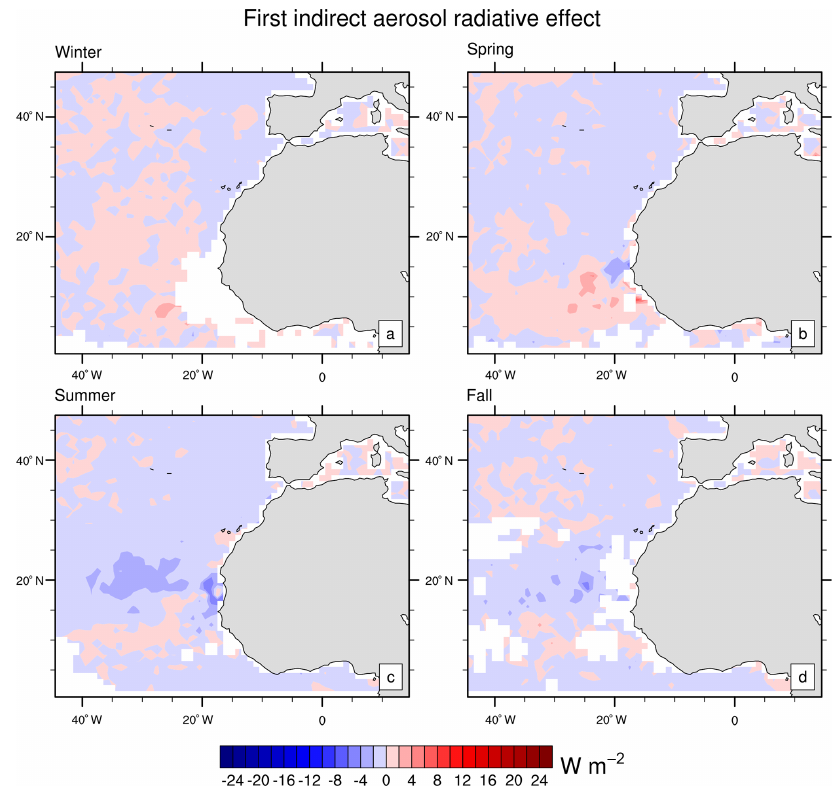
Figure 4. Fist indirect radiative effect (cloud albedo effect) of dust on marine stratocumulus clouds (Wm − 2 ) following Quaas et al. (2008) for (a) winter, (b) spring, (c) summer, and (d)